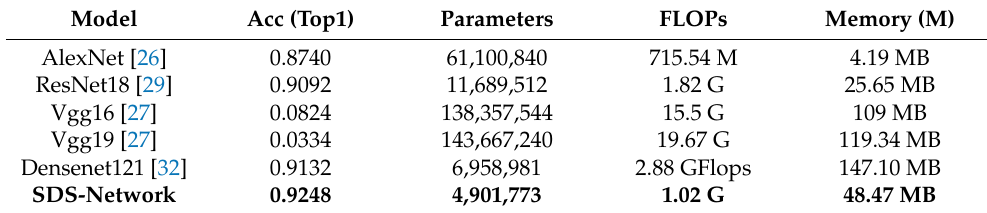
Table 4. Comparison of SDS-Network model and classic